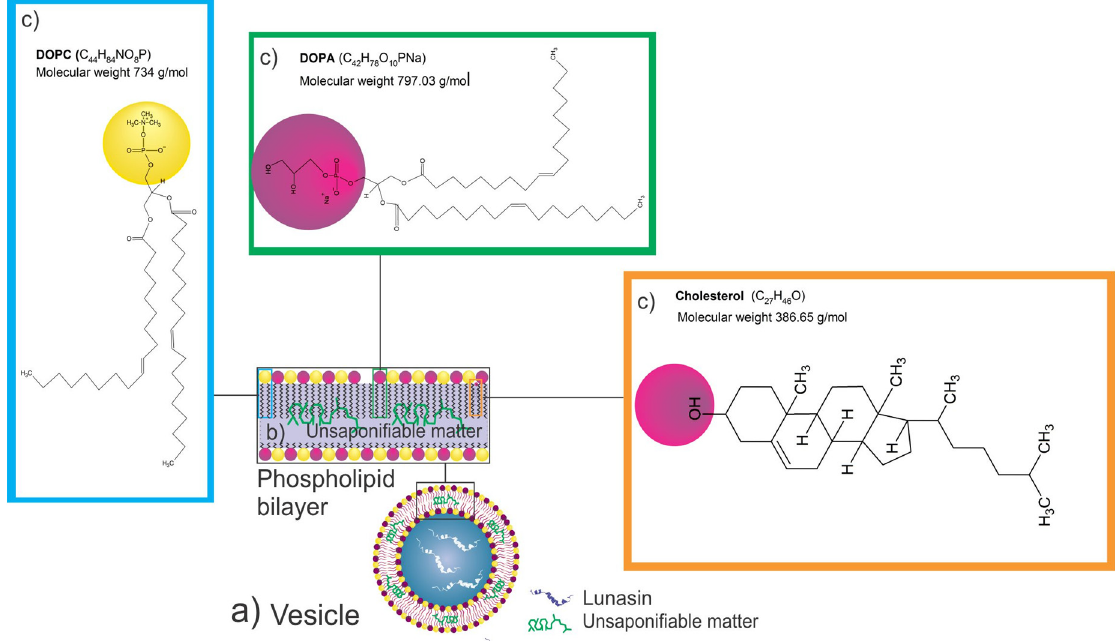
Figure 4. Expected liposome conformation diagram. ( a ) Vesicle (liposomes) loaded with lunasin (white structures) and amaranth unsaponifiable matter (green structures); ( b ) expected amaranth unsaponifiable matter location; ( c ) chemical structures and location of phospholipids (DOPC:DOPA) and cholesterol.